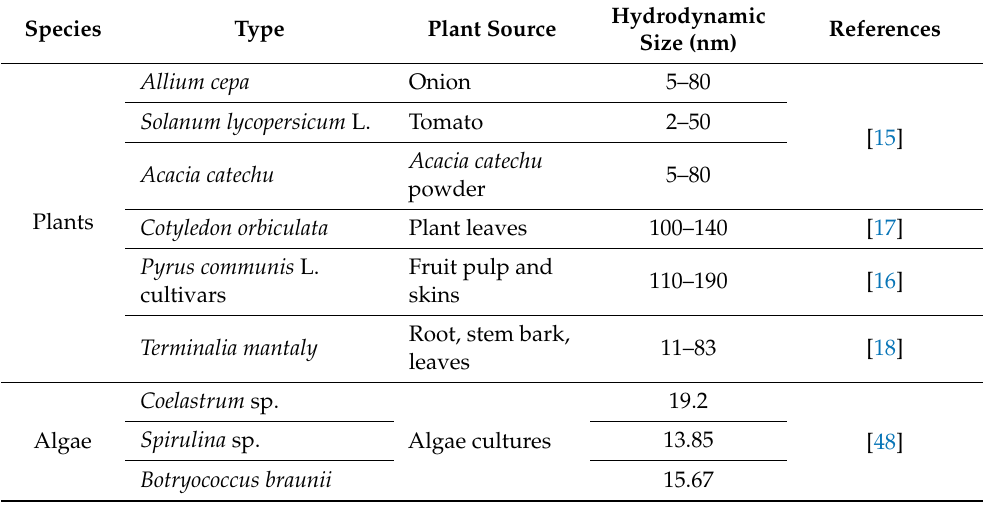
Figure 3. Green synthesis AgNPs using plant extracts. Extracts obtained from various parts of plants are used for bio-reducing and stabilizing AgNPs in a one-step synthesis method. Table 2. AgNPs synthesized from various plant extracts and algae cultures .